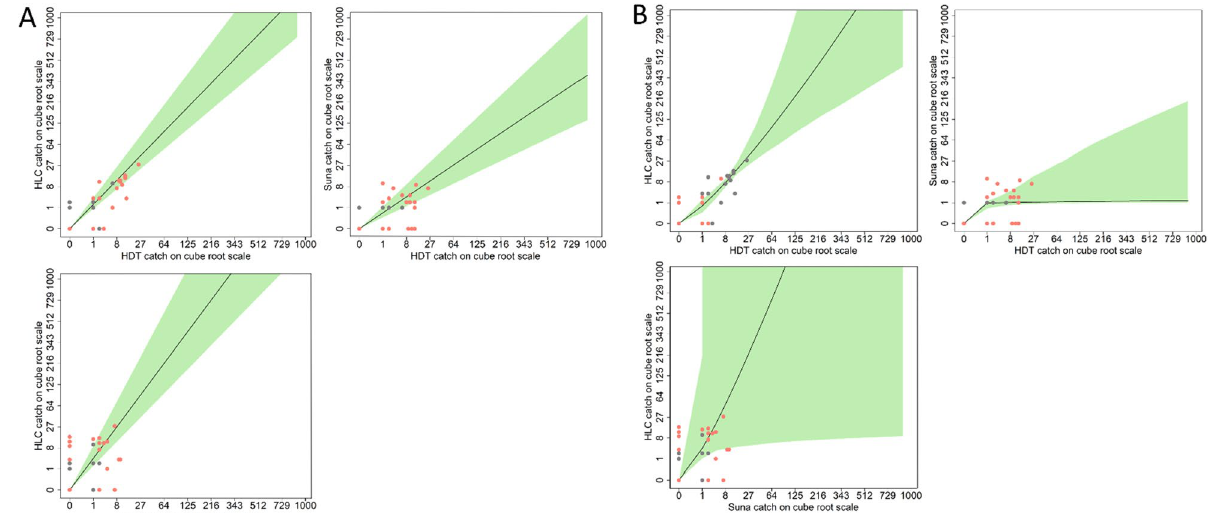
Figure 3. The fitted relative sampling efficiencies for each trap comparison. For each panel the number of mosquitoes caught per night are plotted against each other for the HDT versus HLC (top left), HDT versus Suna (top right) and HLC versus Suna (bottom left). Sampling efficiencies are shown for the linear model in panel A and for the non-linear (power) model in panel B. The shaded green area corresponds to 95% credible intervals for the best fitting curve for each model